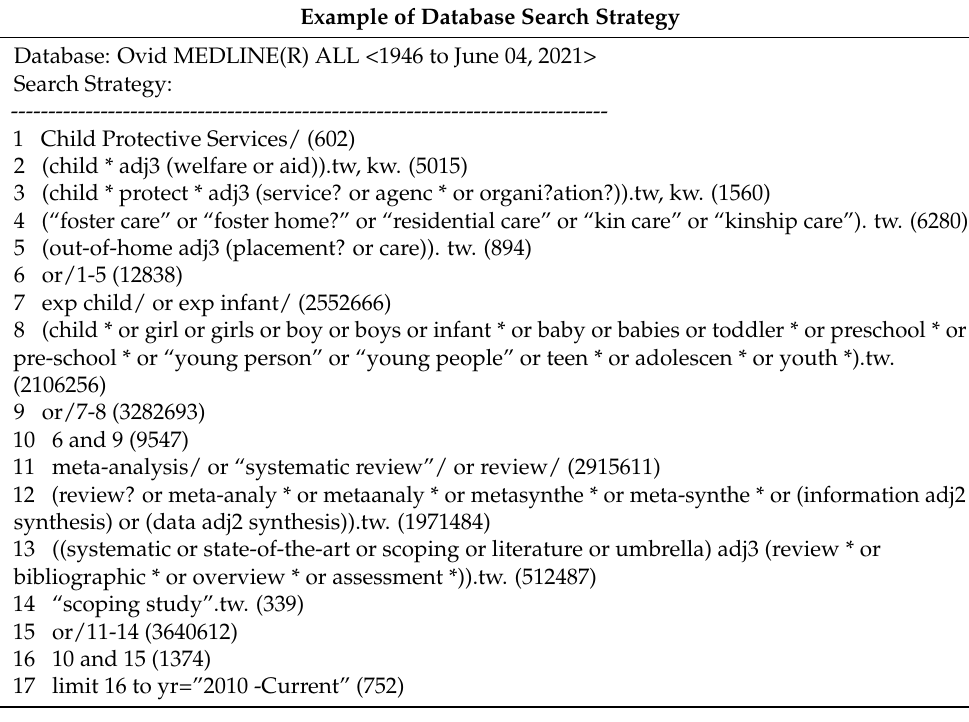
Table 2. Example of database search